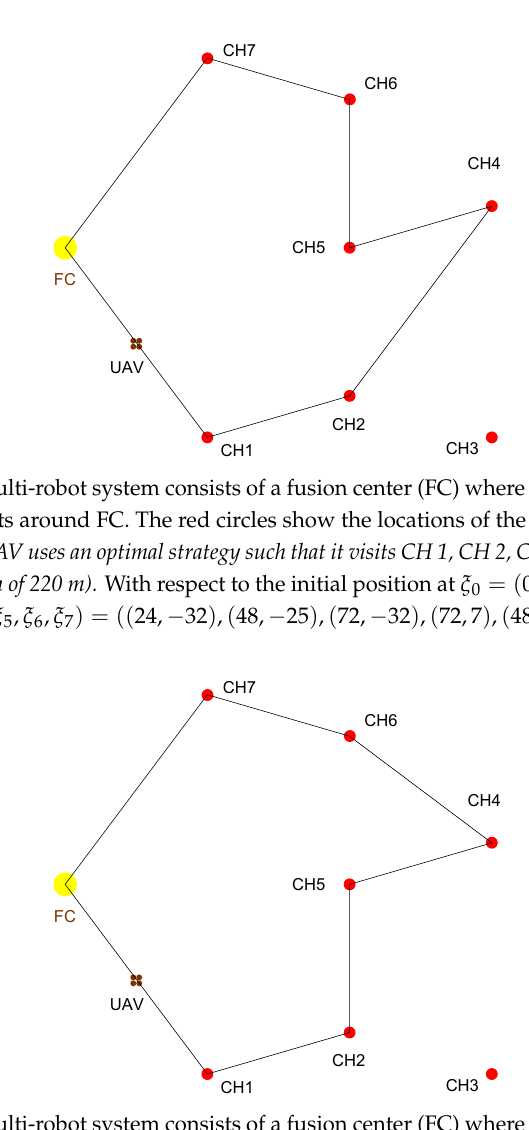
Figure A5. The whole multi-robot system consists of a fusion center (FC) where the UAV starts its route and 7 cluster head (CH) robots around FC. The red circles show the locations of the cluster head (CH) robots in their robot cluster. The UAV uses an optimal strategy such that it visits CH 1, CH 2, CH 5, CH 4, CH 6 and CH 7 in order (The path has a length of 210 m). With respect to the initial position at ξ 0 = ( 0,0 ) , the positions of the CH robots are ( ξ 1 , ξ 2 , ξ 3 , ξ 4 , ξ 5 , ξ 6 , ξ 7 ) = (( 24, − 32 ) , ( 48, − 25 ) , ( 72, − 32 ) , ( 72,7 ) , ( 48,0 ) , ( 48,25 ) , ( 24,32 )) m